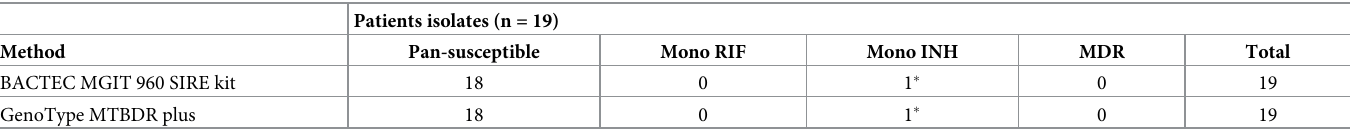
Table 3. Drug Susceptibility Test (DST) results.